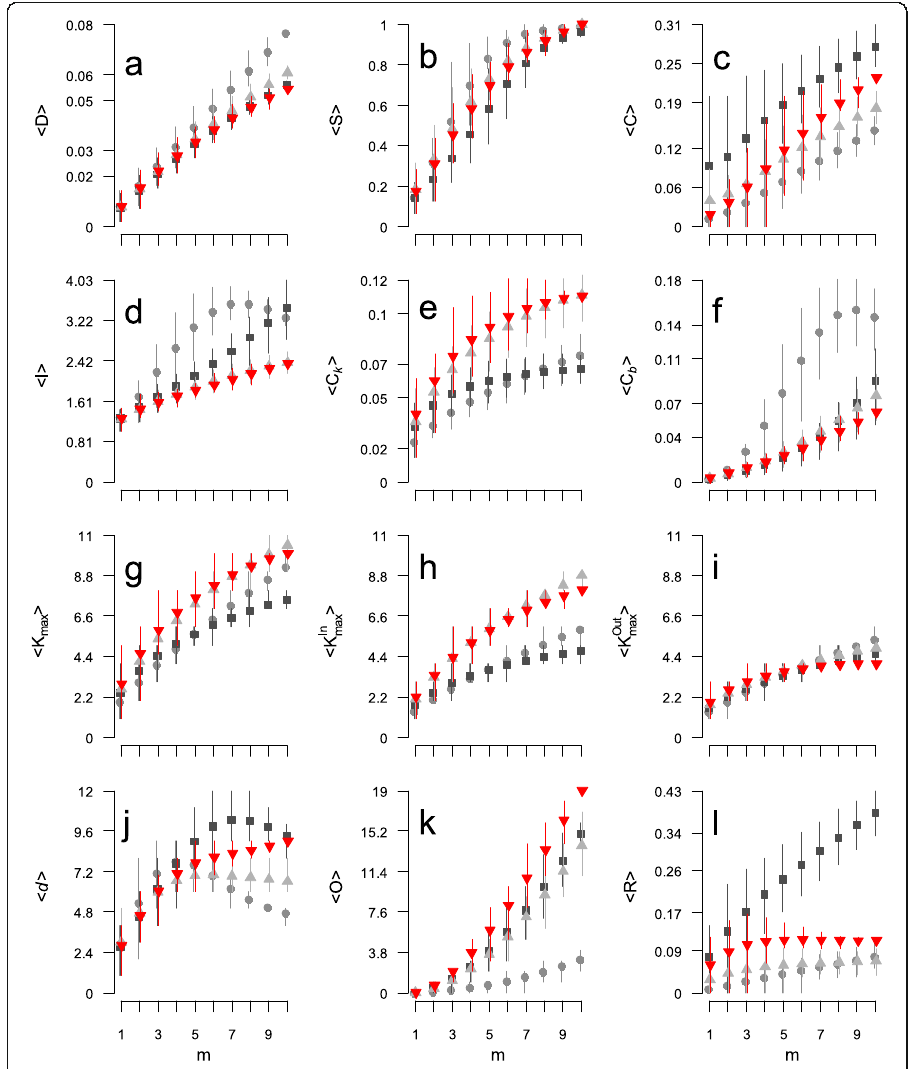
Fig. 3 Comparison between metrics of the multiplex reptile trafficking in Colombia and null models across different levels of plex combination ( m ); each plex represents a different reptile family. Shown are empirical data (red triangle down) along with predictions of models 1 (diamonds), 2 (triangles up), and 3 (boxes). Metrics shown in each panel are: density ( a ), clustering coefficient ( b ), size of the largest component ( c ), average path length ( d ), centralizations by degree and betweenness ( e , f ), maximum degrees ( g - i ), network diameter ( d ), link overlapping ( e ), and reciprocity ( f ). Data points are slightly displaced in the x axis